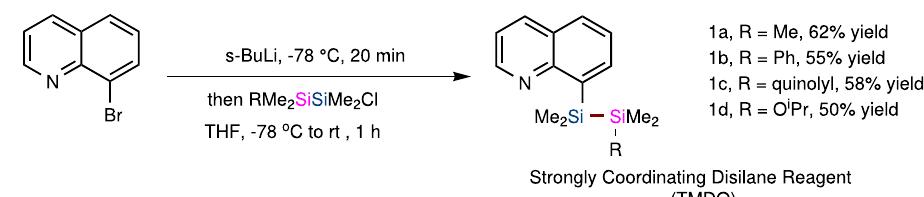
Fig. 2 The synthetic route for producing the strongly coordinating disilane TMDQ reagent. The detailed procedures for preparation of these disilane TMDQ reagents have been presented in Supplementary